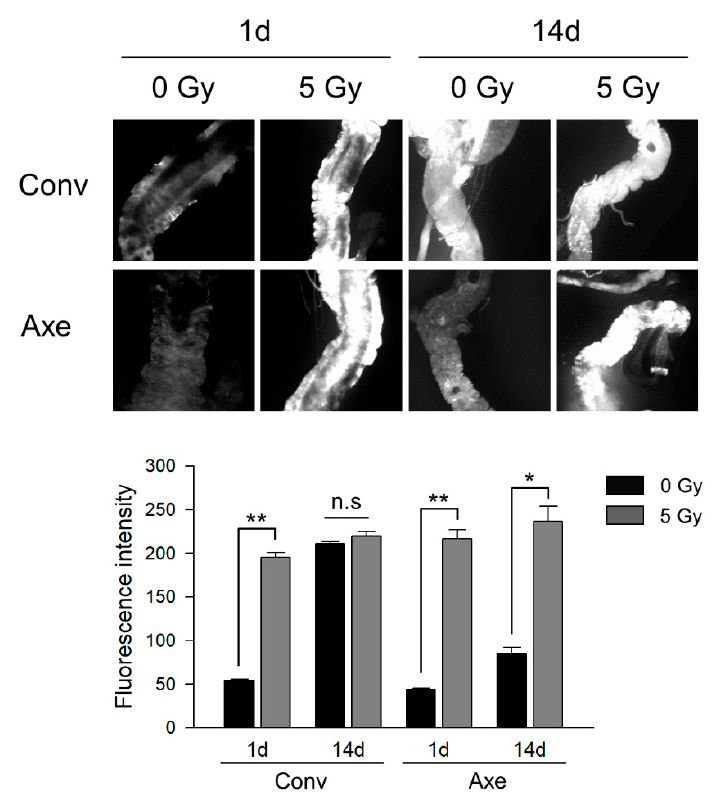
Figure 5. Effects of commensal microbes on ROS occurrence in the gut of D . melanogaster after γ -ray irradiation. ROS detection with DCFDA in the gut of the Conv or Axe flies at 1 and 14 days after γ -ray irradiation. Original magnification was 100 × . The graph represents the fluorescence intensity based on microscopy images. Student’s t -test, * p < 0.05, ** p < 0.005. n.s, not significant. The error bars represent the SEM.